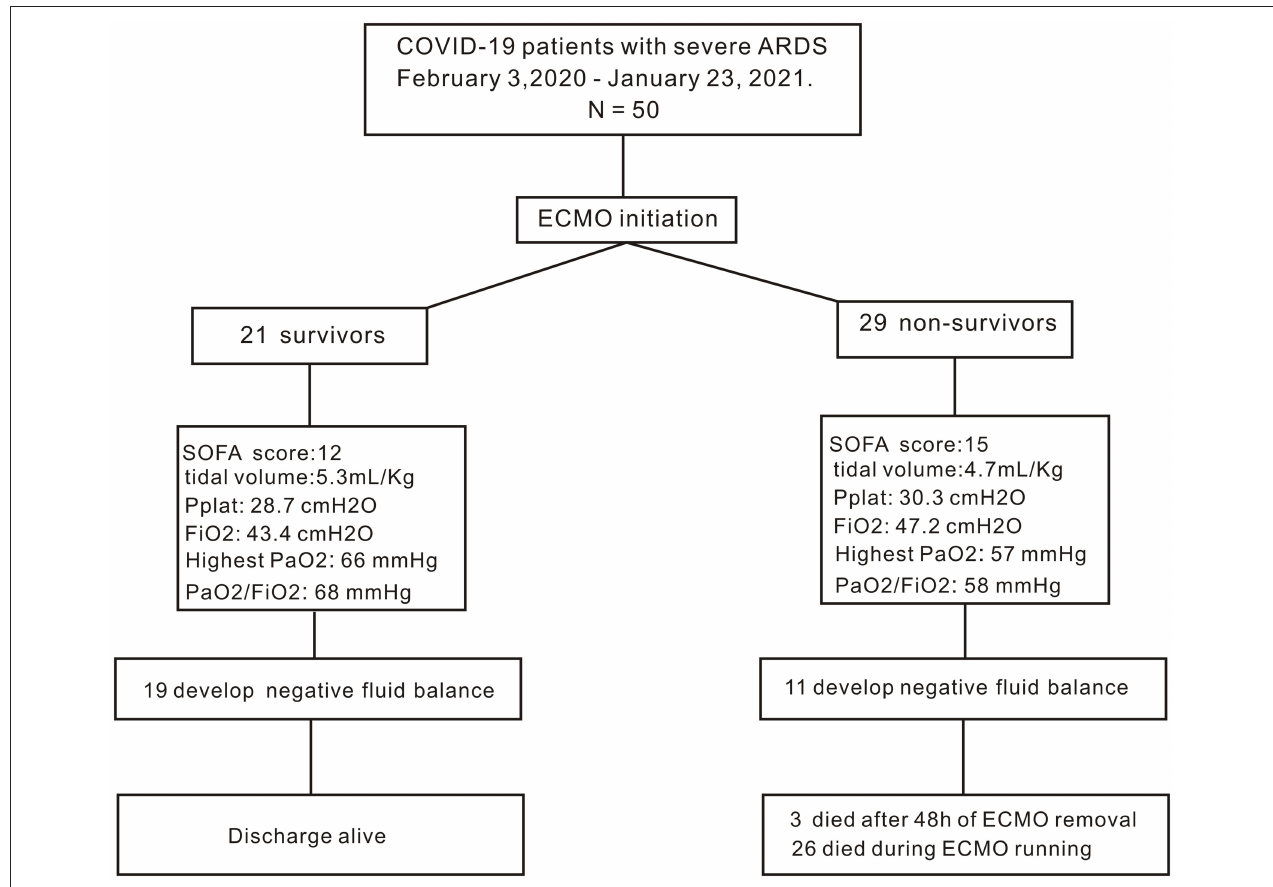
FIGURE 1 | Flow diagram of the study. PaO 2 , arterial partial pressure of oxygen; PaO 2 /FiO 2 , the ratio of arterial partial pressure of oxygen to fraction of inspired oxygen; FiO 2 : the fraction of inspired